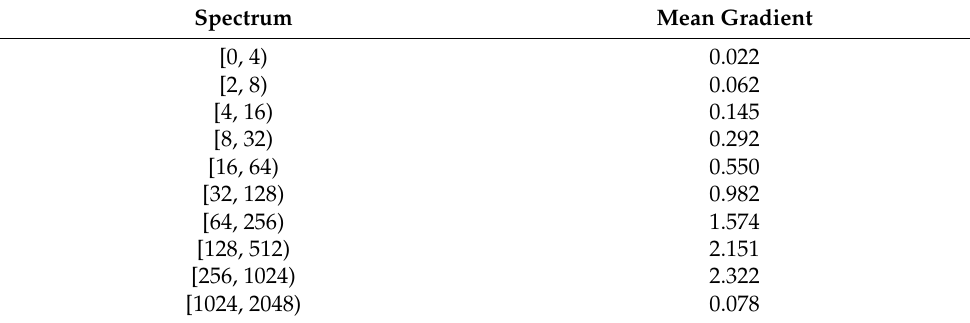
Table 1. Mean gradients of different frequency components.